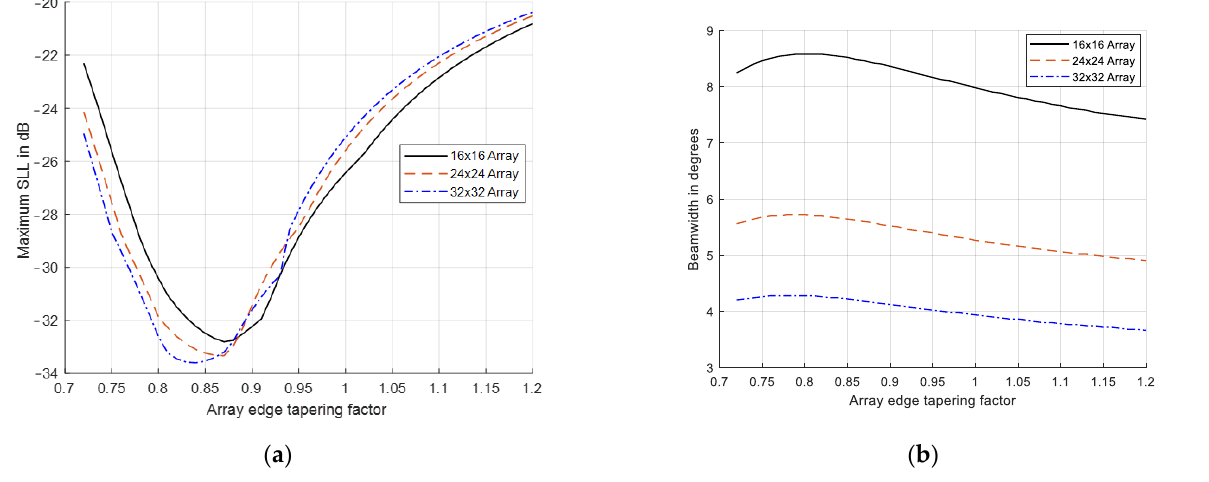
Figure 9. ( a ) Optimizing radial tapered Hamming window at different array sizes. ( b ) Beamwidth variation with the array edge tapering factor at different array sizes.